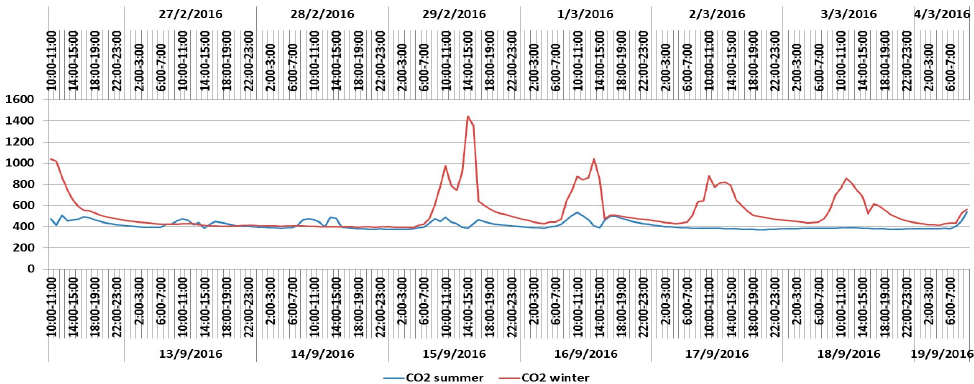
Figure 9. CO 2 levels of Building B, during winter and summer monitoring.